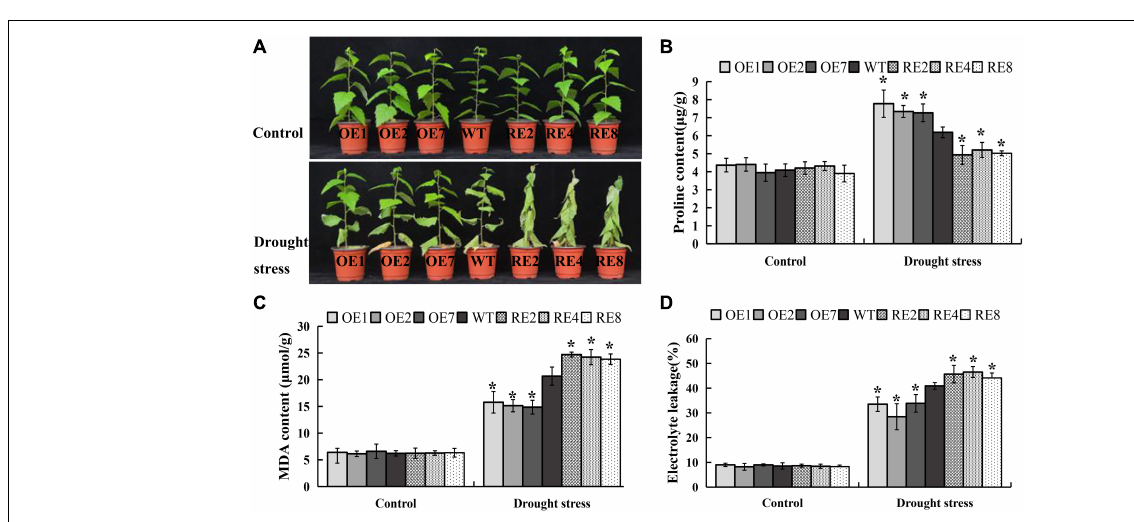
FIGURE 1 | Subcellular localization analysis of BpMYB123.